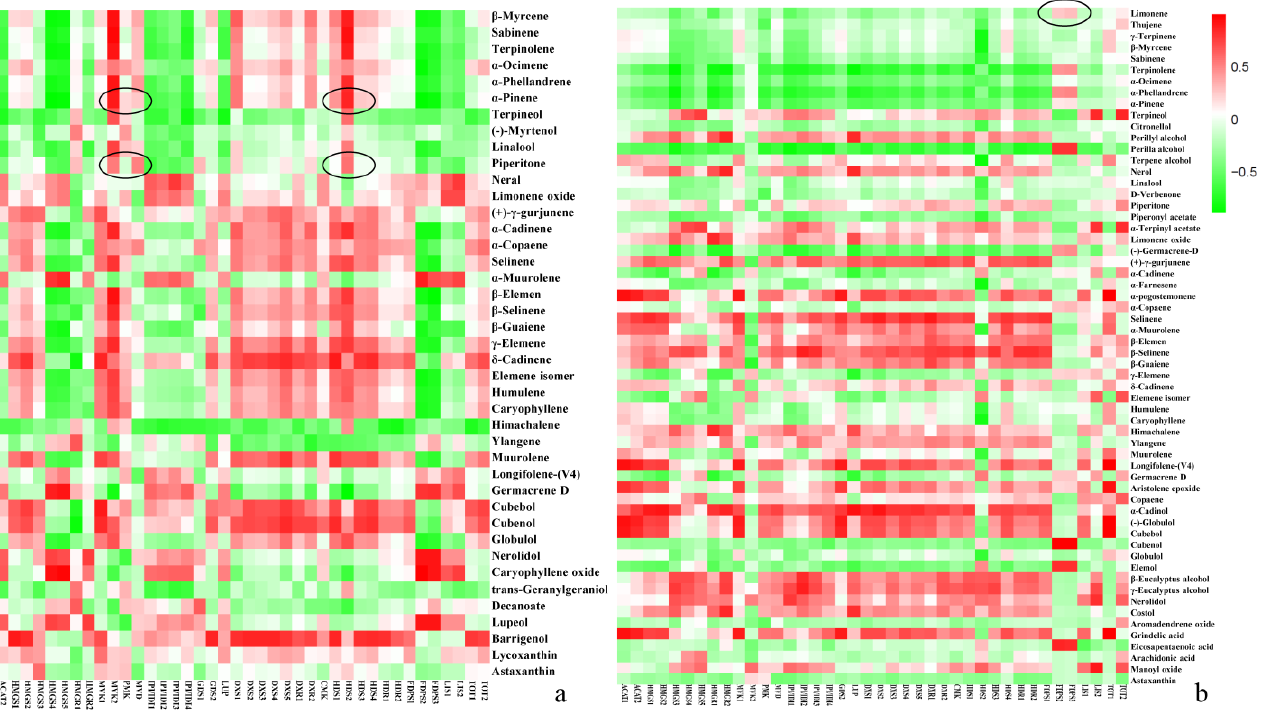
Figure 6. Intergroup correlation analysis of terpenoids and terpenoid synthesis-related genes in green and red prickly ash. ( a ) Intergroup correlation analysis of terpenoids and terpenoid synthesis-related genes in green prickly ash fruit. ( b ) Intergroup correlation analysis of terpenoids and terpenoid synthesis-related genes in red prickly ash fruit.